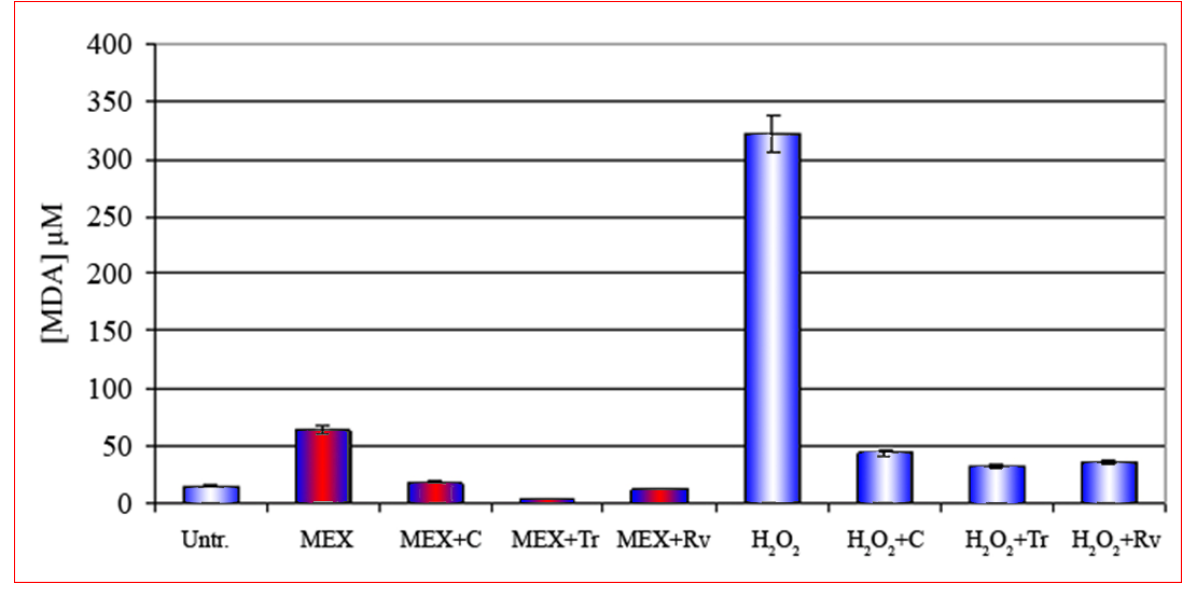
Figure 4. Reduction of the production of MDA in 3t6 cells after treatment with MEX (red central area) in the presence of three different antioxidant curcumin (C), trolox (Tr) and resveratrol (Rv) shown respectively in the third, fourth and fifth bar. These compounds reduce drastically the oxidative stress also after treatment with H MEX (bars with white central area). Error bars represent the standard error of the standard of the mean (mean ±